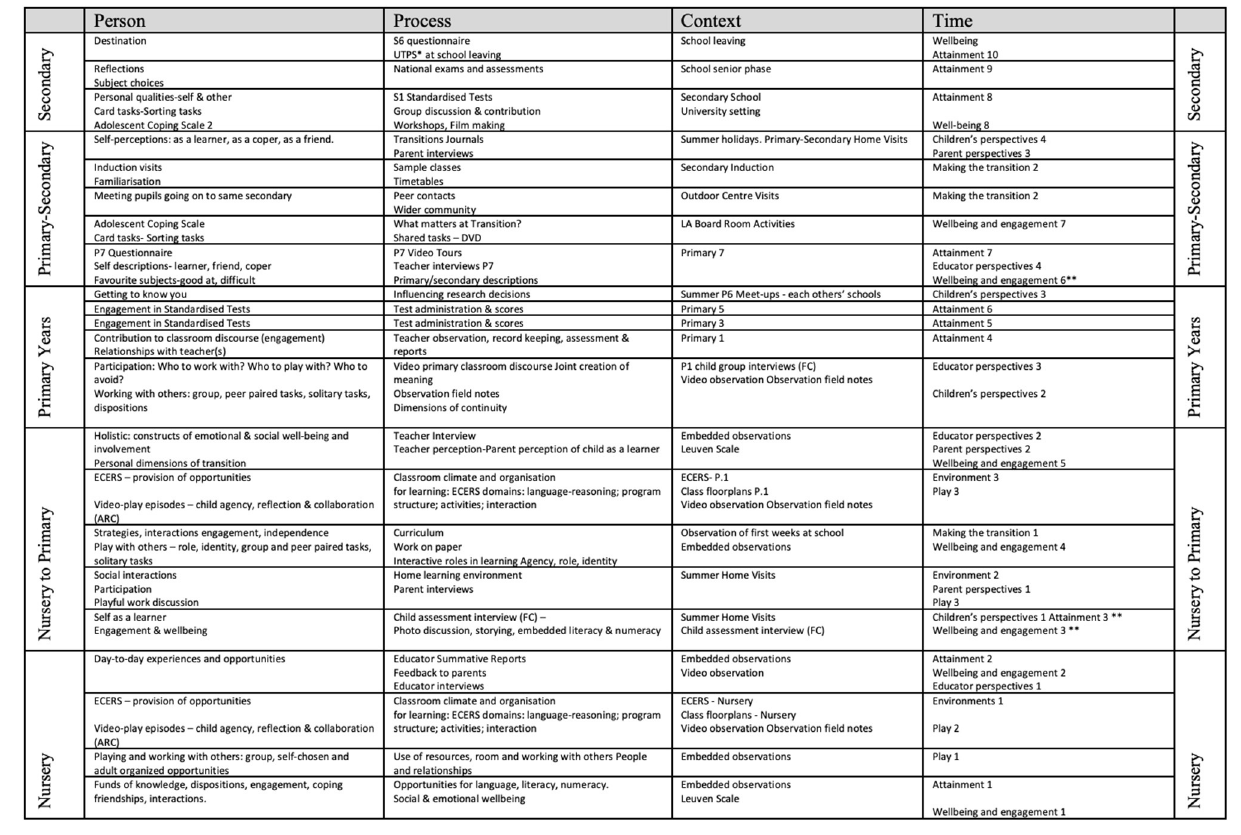
FIGURE 1 | Person-Process-Context-Time Model of Data Collected. *UTPS, Universal Tariff Points Score; ECERS, Early Childhood Environment Rating Scale; *Timepoints not included in